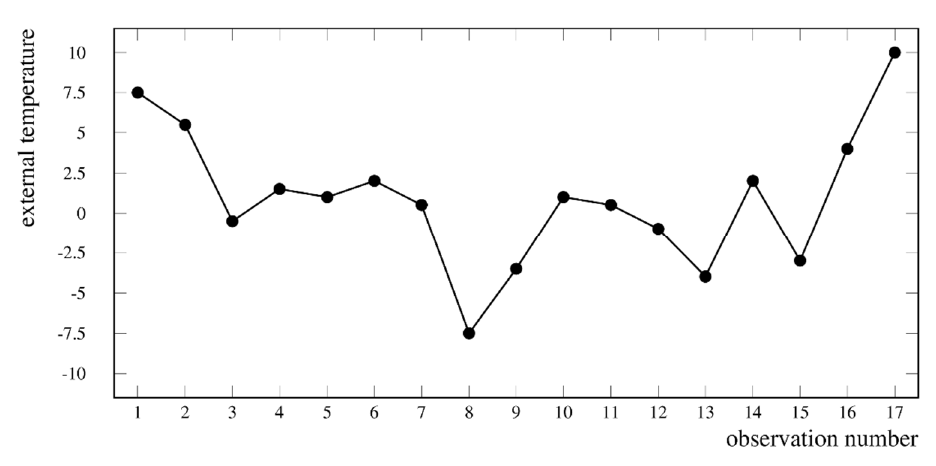
Figure 5. External temperature at 4 p.m. of each observation day as reported by meteo.waw.pl.